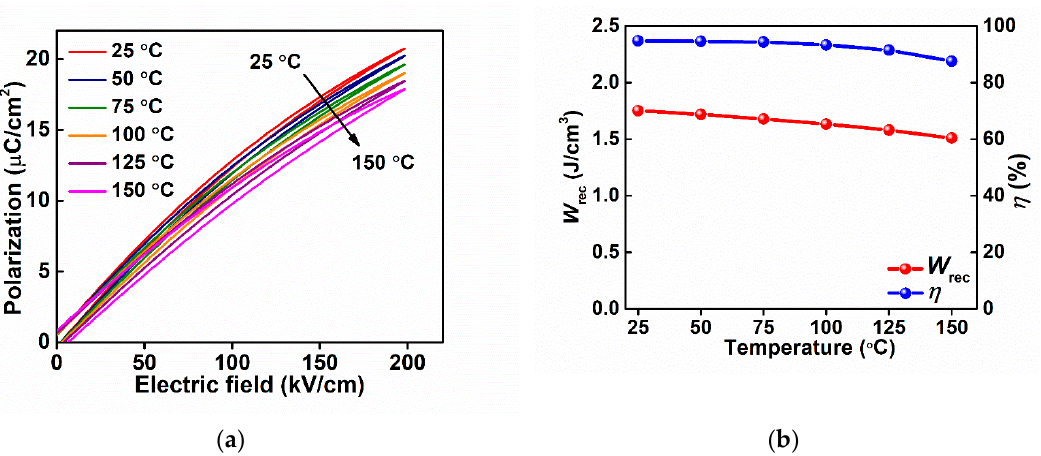
Figure 6. ( a ) The unipolar P – E loops for 6BMZ ceramic at different temperature at 200 kV/cm; ( b ) W r and η of 6BMZ ceramic as functions of temperature.